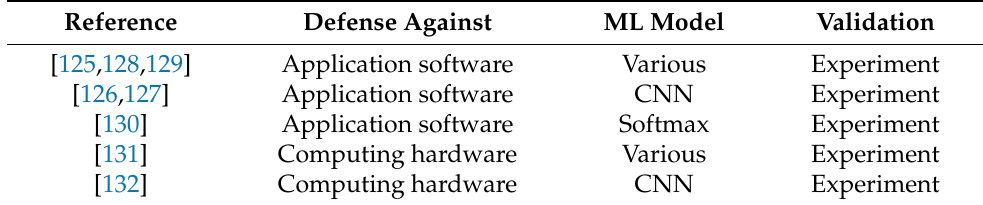
Table 3. Summary of ML-based anomaly detection methods in the application